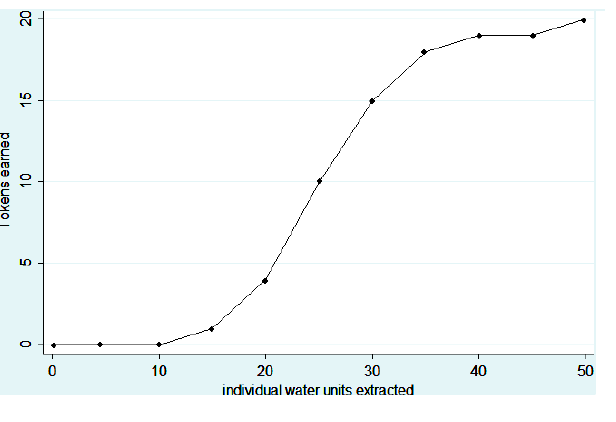
Fig. 3. Pay-offs depending on water extraction decisions. Based on Janssen et al. (2011 b